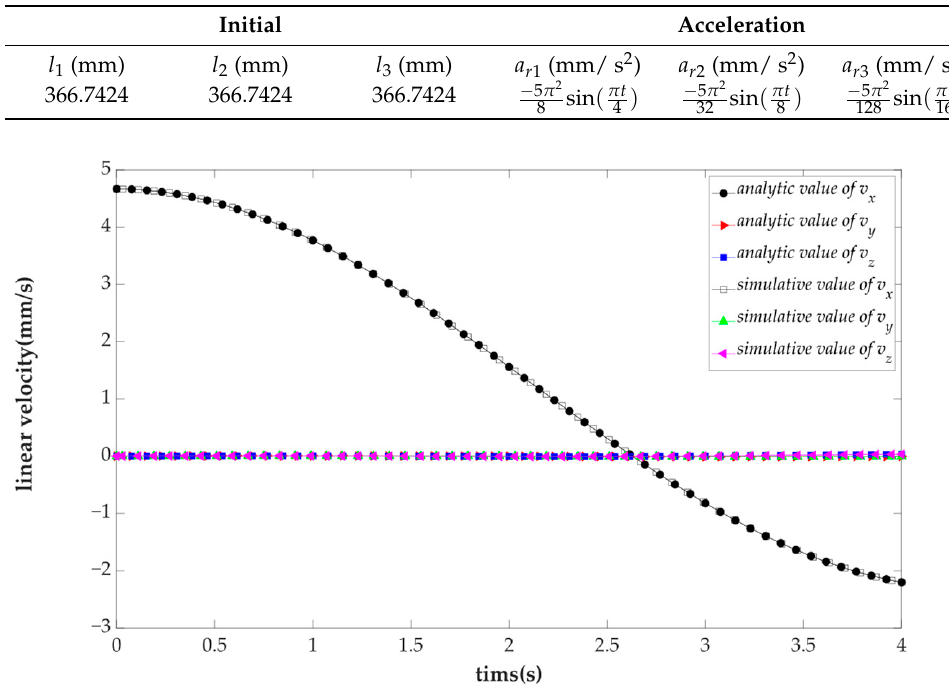
Table 3. The initial parameters of 3 actuators and their acceleration.